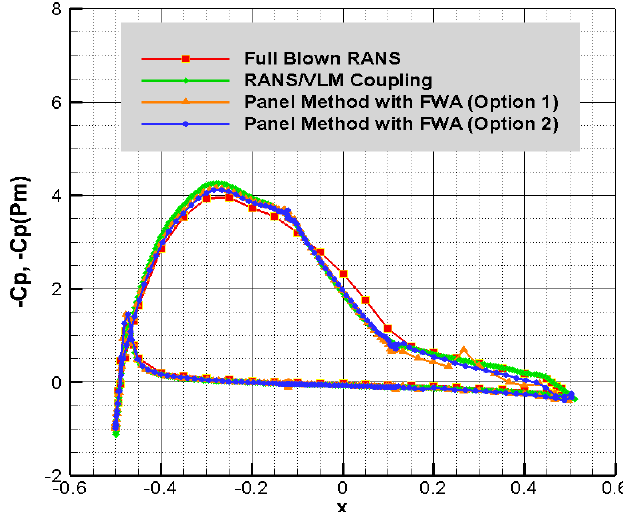
Figure 16. Circumferentially averaged pressure distribution on the duct, predicted by the present method (Option 1 or 2), RANS/VLM coupling method, and RANS simulation at the design advance ratio of 0.50.